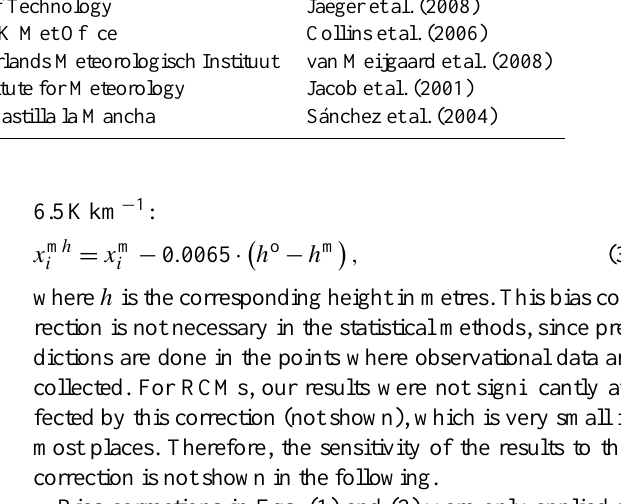
Table 2. Summary of the ENSEMBLES RCM simulations used in the study.